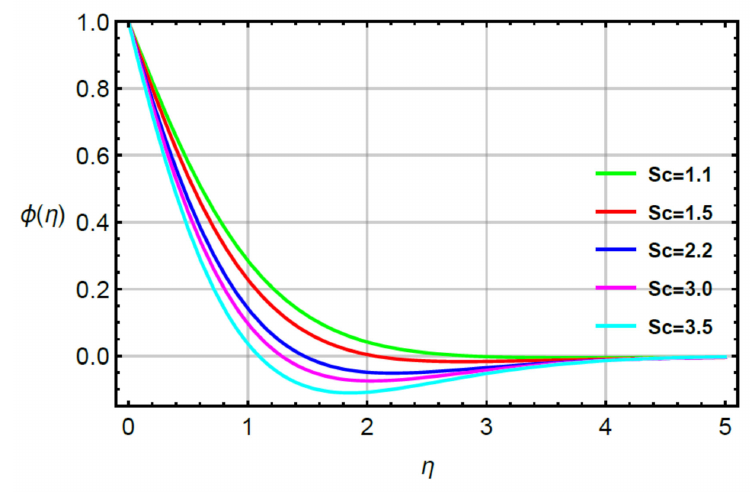
Figure 11. Behavior of φ ( η ) for Sc when R = 0.1, α 1 = 0.2 = α 2 , γ 2 = 0.3, M = 0.1, δ = 0.8.